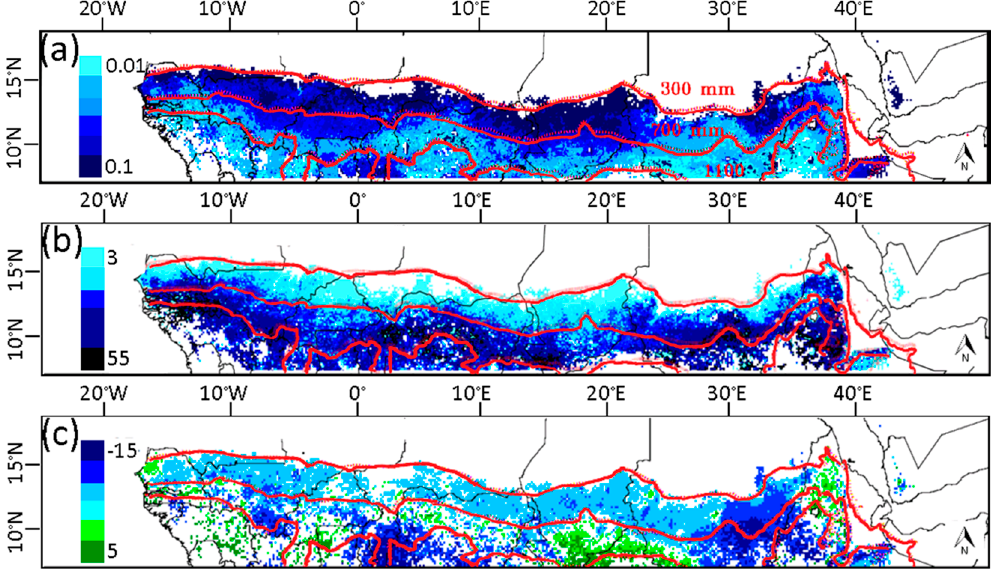
Figure 9. Regression coefficients of ( a ) precipitation ( b ) specific humidity; and ( c ) air temperature obtained from the multivariate regressions of growing season Σ NDVI on precipitation, specific humidity and temperature. Missing values (white pixels) are areas with high multicollinearity between explanatory variables, or where the coefficients were insignificantly different from zero ( p > 0.05). The red lines from north to south are the 300 mm, 700 mm and 1100 mm rainfall isohyets.